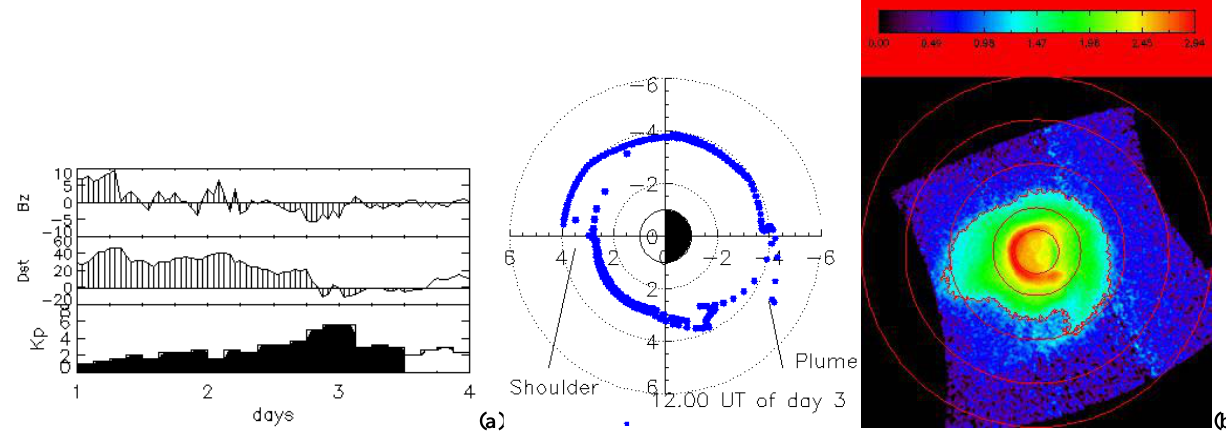
Fig. 8: Same as Fig. 1 for June 25, 2000, 21h00 (left panel (a), simulation) and 21h03 UT (right panel (b), EUV observation).